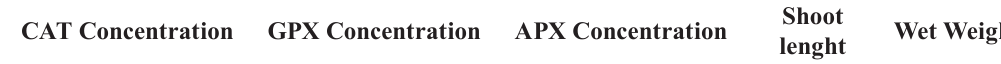
TABLE IV - Pearson correlations among growth and antioxidant enzymes activity of radish seedlings affected by allelopathic potential of Khorasan’s root residue grown drought stress